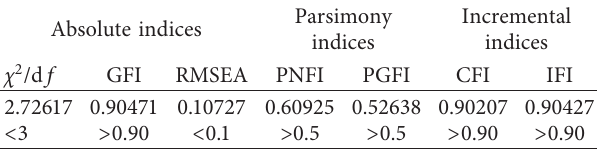
Table 9: Model fitting index of the external